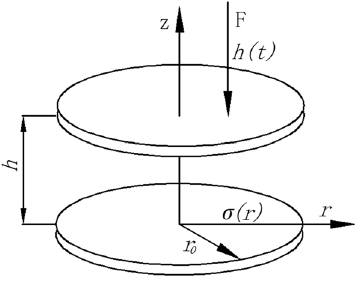
Figure 1. The sketch of the compression of MR fluids between two parallel